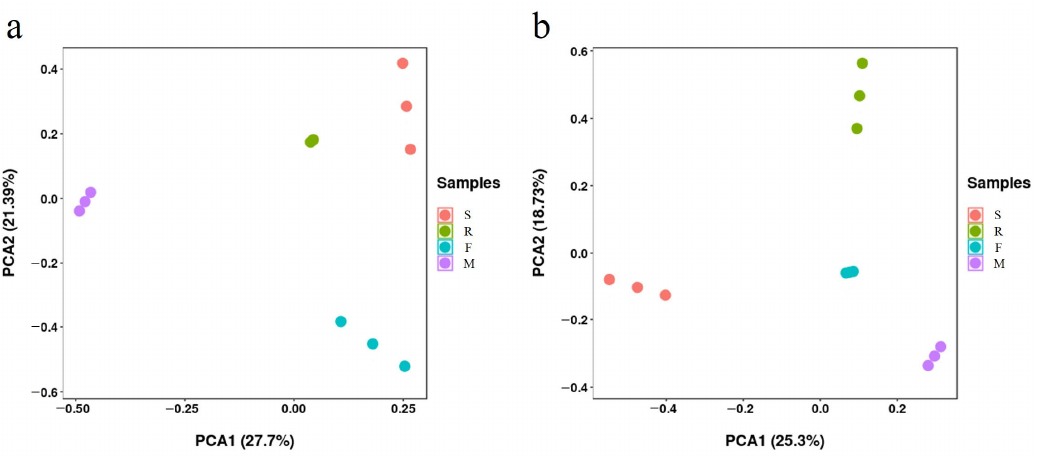
Figure 4. Principal component analysis of soil bacterial ( a ) and fungal ( b ) community. S, R, F, and M represent the seedling stage, rapid growth stage, flowering stage, and maturity stage, respec ‐ tively.